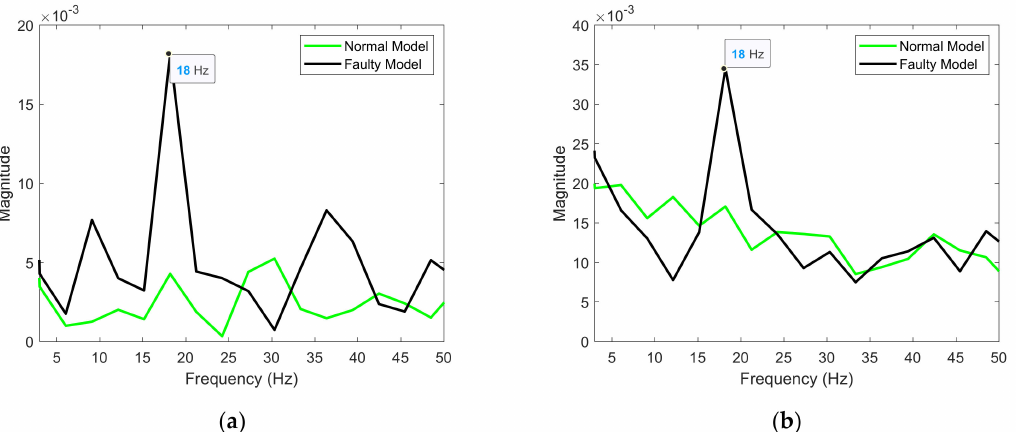
Figure 9. Comparison of envelope spectrum ( a ) without an impulsive noise and ( b ) in the presence of an impulsive